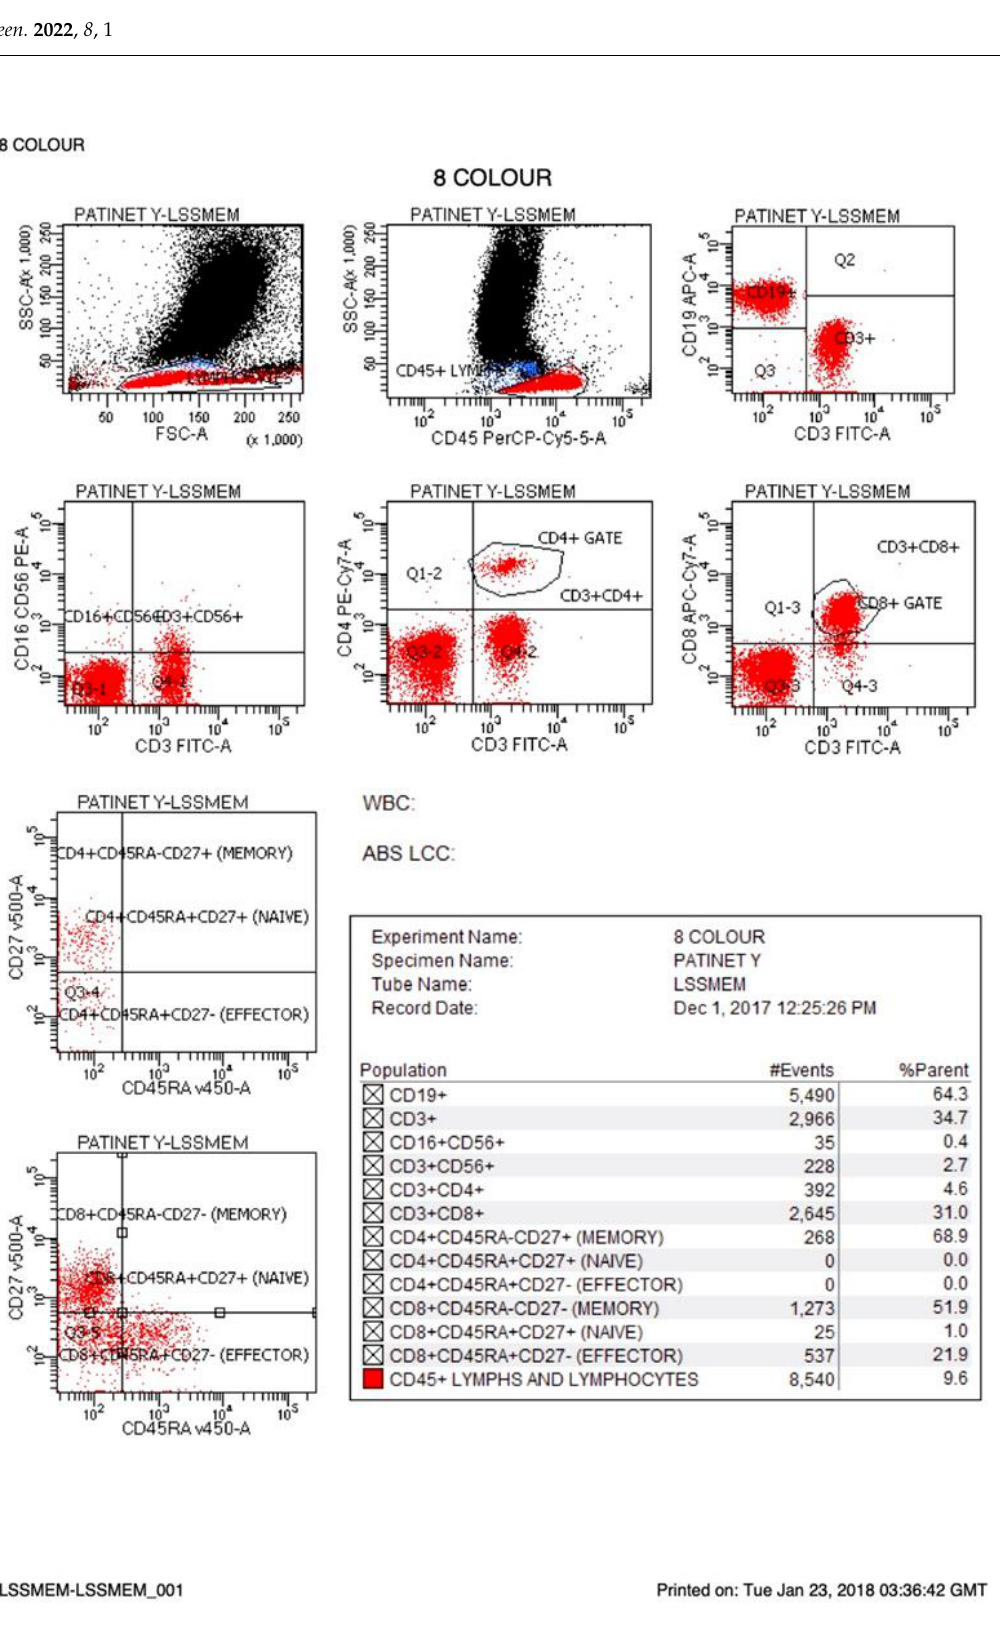
Figure 1. ( a ) Normal FACs plots. The FACs plots from a normal infant are shown. The cells markers for each plot are listed on the X and Y axis and the percentages for each cell population are provided in the statistics box. The CD makers and the cells they identify are summarised in Table 1. ( b ) FACs plots from an infant affected by